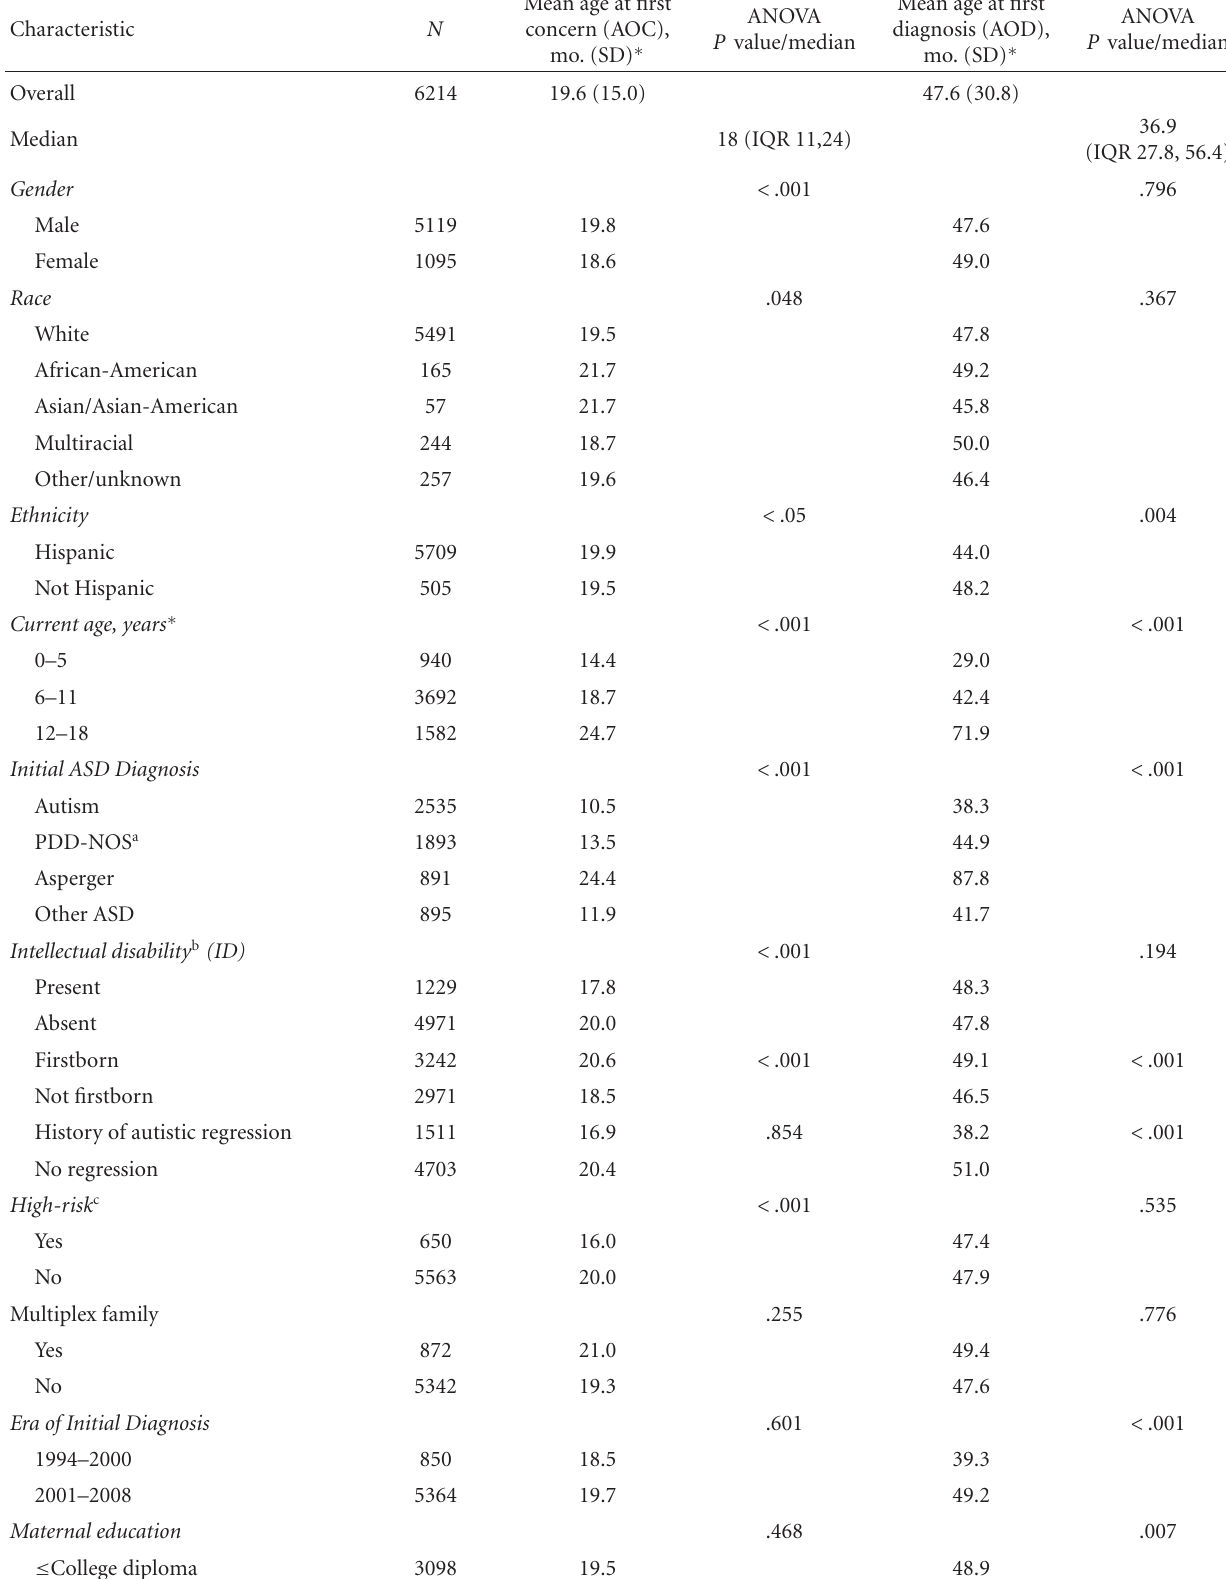
Table 1: Comparison of mean age of first concern (AOC) and age of first diagnosis (AOD) by characteristic ( N = 6214); univariate testing by ANOVA on log-transformed AOC and